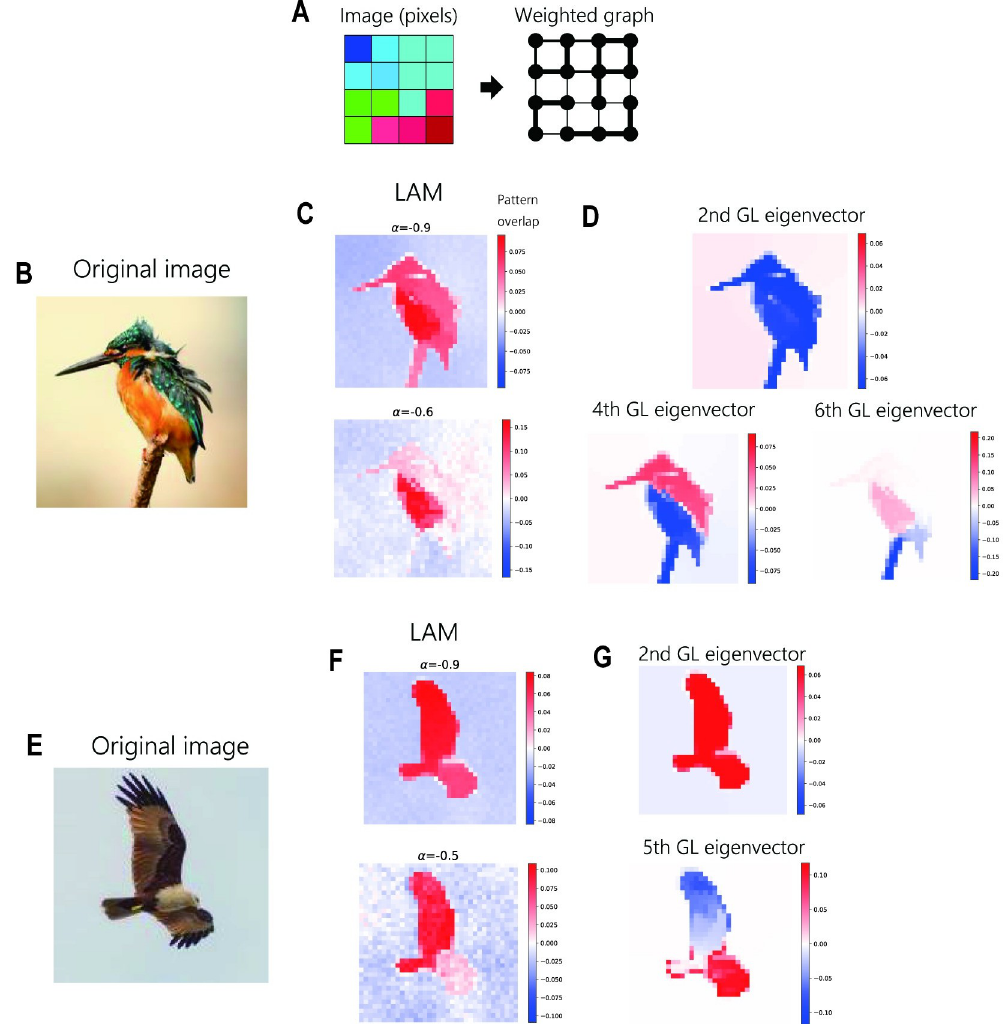
Fig 5. Image segmentation by LAM. (A) Conversion of images into a weighted graph. We regarded each pixel as a node and determined link weights by spatial proximity and similarity of RGB values. (B,E) Original hi-resolution images used for the segmentation task. We used down-sampled images for the construction of graphs. (C,F) Pattern overlaps obtained after the simulation of LAM with different values of α . (D,G) Representative GL eigenvectors corresponding to segments obtained by